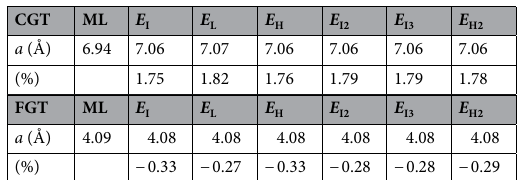
Table 1. Lattice constant variation in the FM heterobilayer with a twist angle of 30°. During the relaxation of the heterobilayer, the lattice constants of CGT and FGT become tensile strained and compressive strained,